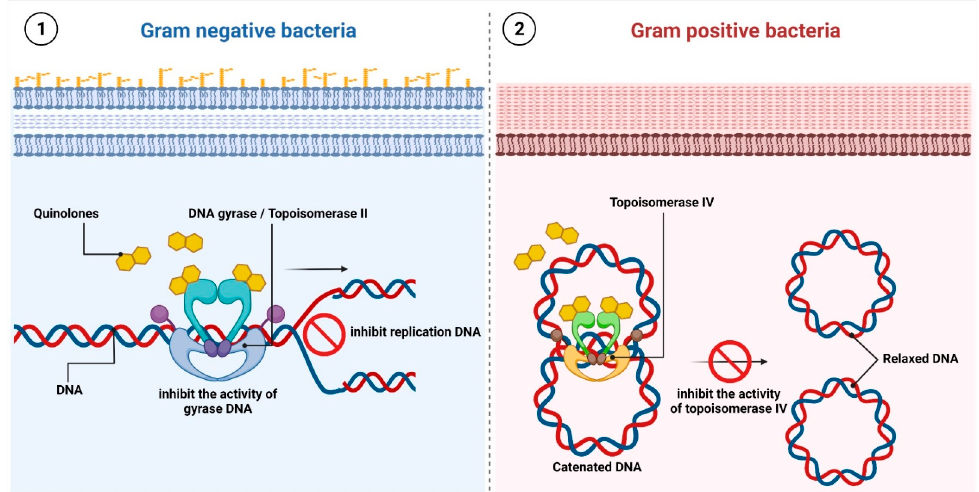
Figure 3. Mechanism of action of quinolones in ( 1 ) Gram-positive and ( 2 ) Gram-negative bacteria. Figure created with Biorender.com.